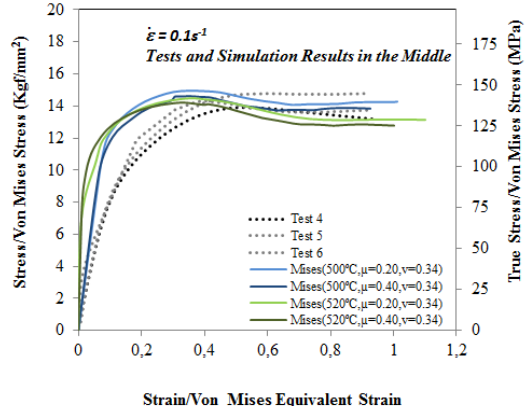
Figure 12 are the True Stress vs. True Strain curves obtained experimentally and the Von Mises Stress vs. Von Mises Equivalent Strain obtained from the simulation in the middle of the sample for a strain rate of 0.1 s -1 .